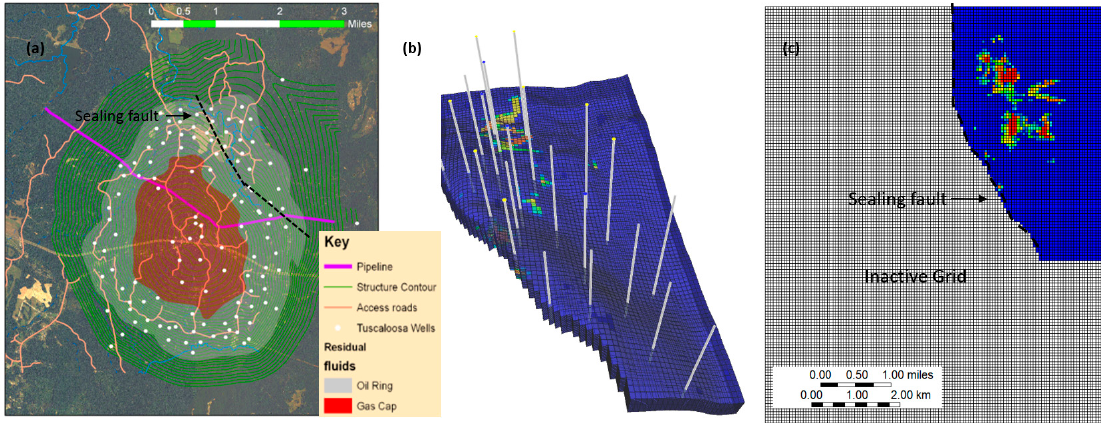
Figure 1. ( a ) Structural contour map; ( b ) sector model showing structure and location of injection and production wells; ( c ) active and inactive grids used for reservoir simulation. The sealing fault is a closed boundary.